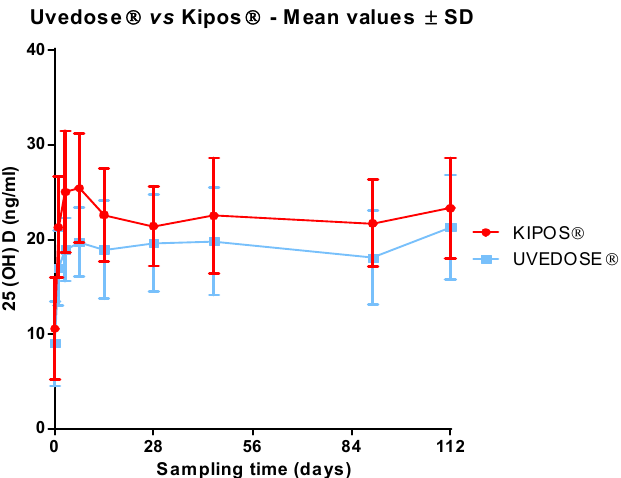
Figure 1. Profile of serum 25(OH)D levels after administration of a single dose of 100,000 UI of vitamin D3.